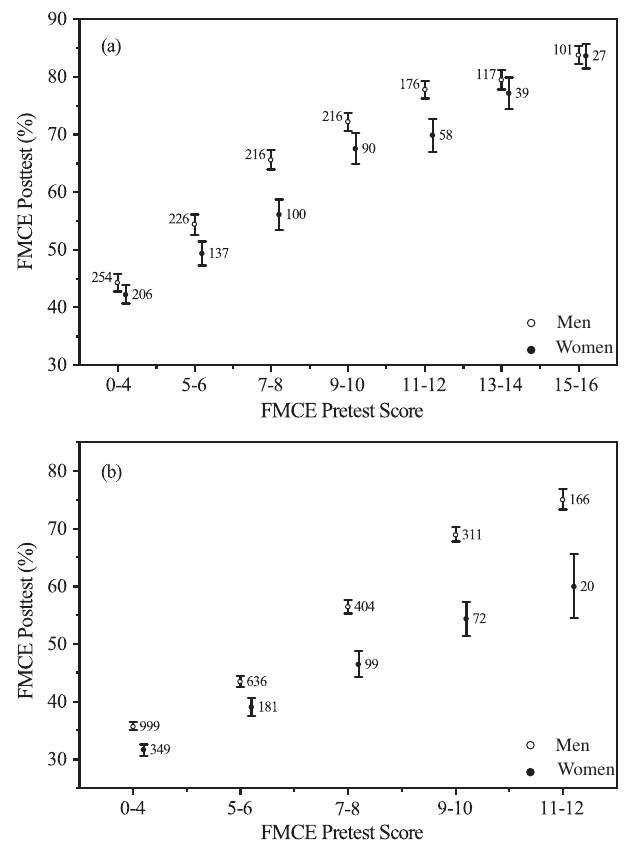
FIG. 2. FMCE post-test percentage vs FMCE pretest: (a) Sam- ple 1 and (b) sample 3A. The number next to the data point is the number of students within each pretest range. [ B ¼ 3 . 34 , SE ¼ 0 . 92 ; t ð 3 ; 045 Þ ¼ 3 . 62 , p < 0 . 001 ]. As